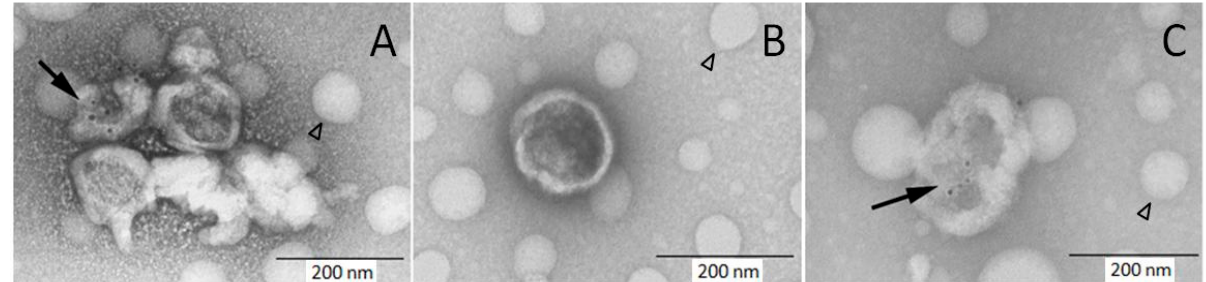
Figure 2. Immune electron microscopy demonstrates the presence of platelet EVs in cord blood plasma. Samples were labeled with CD41 PE MAb and secondary antibody conjugated with colloidal gold followed by staining with uranyl acetate. Some of visualized EVs are decorated with colloidal gold (( A , C ) black arrow) and some are non-labeled ( A , B ). The round hollow structures are artifacts present on carbon grids (arrowhead).